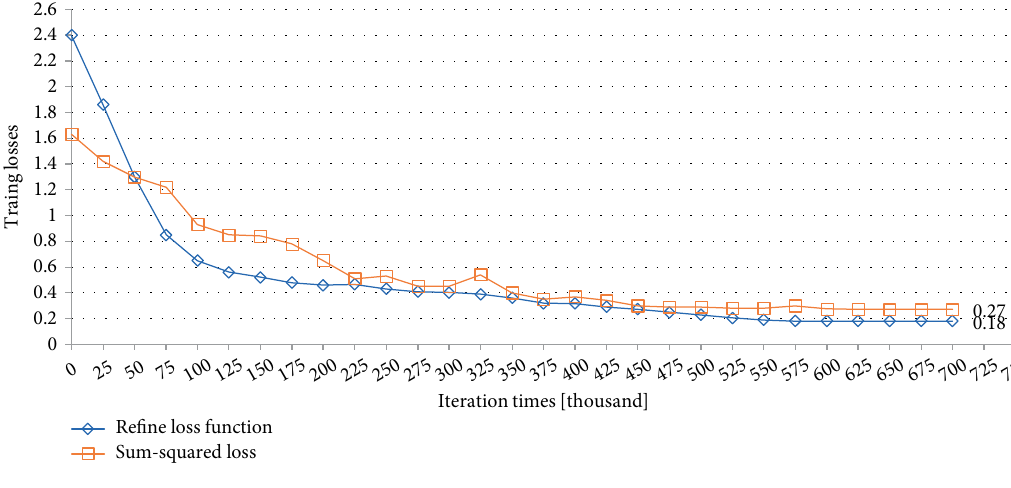
Figure 21: Effect of loss function on training